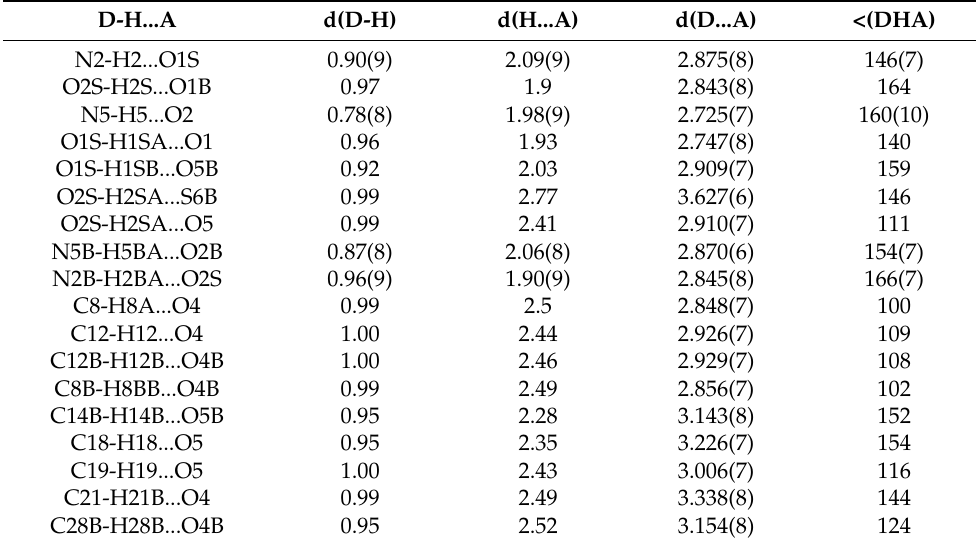
Table 3. Hydrogen bonds for 5a (Å and ◦